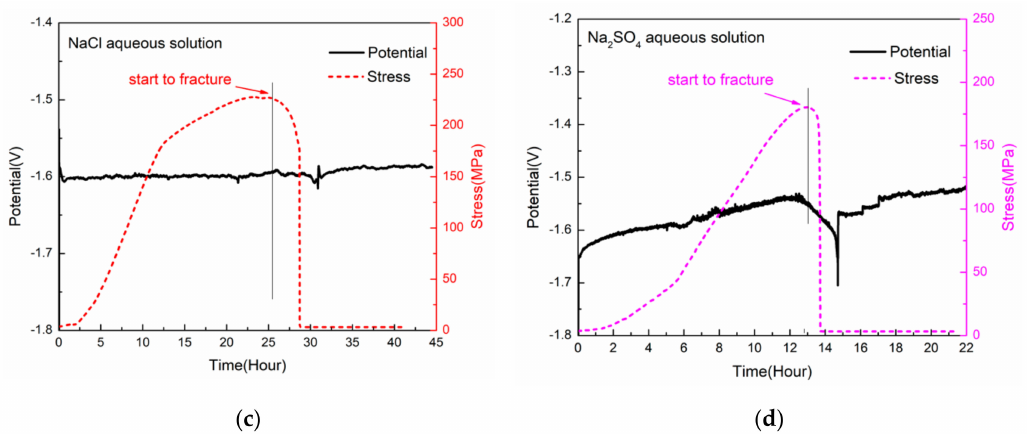
Figure 6. The corrosion open circuit potential curves during SSRT in di ff erent aqueous solutions ( a ), the corrosion open circuit potential curve with SSRT curve in distilled water ( b ), the NaCl aqueous solution ( c ), and the Na 2 SO 4 aqueous solution ( d